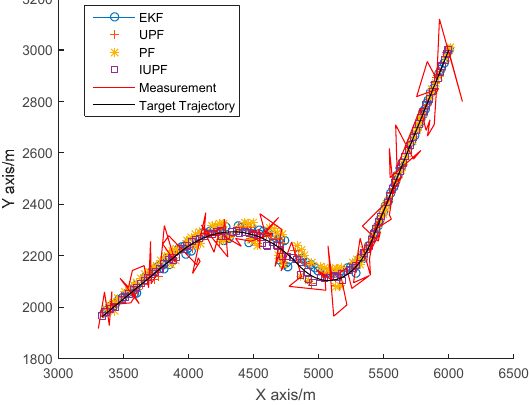
Figure 7. Single-target simulation experiment prediction trajectories.